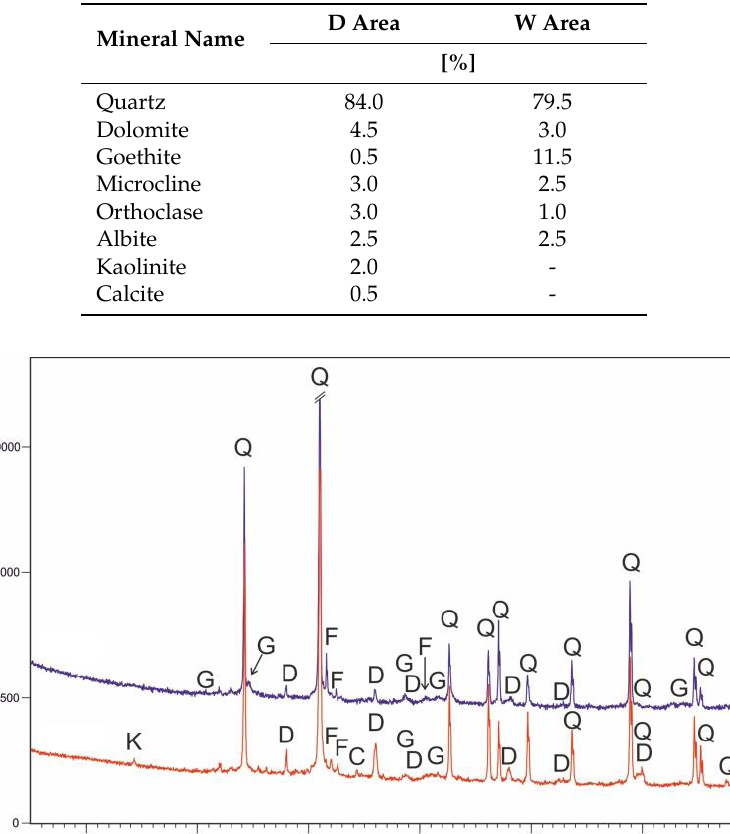
Table 3. Semiquantitative mineralogical analysis of XRD results.